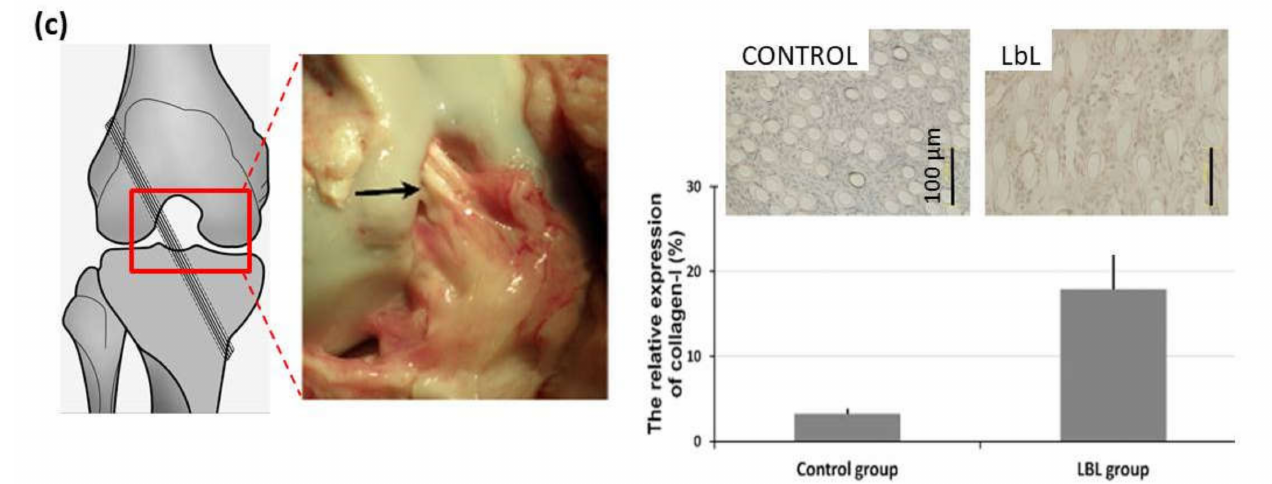
Figure 7. ( a ) Post-operative view of the implanted PLGA tube maintained by suture wires (top), C µ CT reconstructions (center) taken at 8 weeks after implantation at different doses of BMP-2 (scale bar = 5 mm) (center) and bone volume ratio at 8 weeks (bottom) (Adapted and reprinted with permission from [106]; Copyright 2016 Michael Bouyer et al., Published by Elsevier Ltd.); ( b ) Schematic representation of bioinstructive (CHI/ALG-RGD) 6 multilayers over liquefied ALG microchannels embedded in photocross-linkable glycidyl methacrylated xanthan gum (XG-GMA) hydrogels (top). Fluorescence microscopy image of a 3D ALG sacrificial microfiber coated with (RITC-CHI/ALG) 6 multilayer film (bottom- left), and live/dead confocal micrographs of HUVECs seeded for 3 days in the microchannels (bottom-right) (Reprinted with permission from [113]; Copyright 2021 by Cristiana F. V. Sousa et al. Licensee MDPI); ( c ) PET ligament, surgical schematic diagram of an anterior cruciate ligament (ACL) reconstruction model, and gross graft sample observation 3 months after operation in a porcine model (left). Immunohistochemical staining for collagen type I and relative expression of collagen type I (right) (Adapted and reprinted with permission from [114]. Copyright 2012 Acta Materialia Inc. Published by Elsevier Ltd. All rights